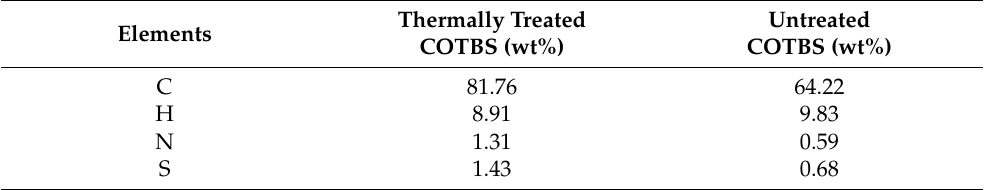
Table 1. Elemental Analysis of asphaltene extracted from thermally treated and untreated COTBS.